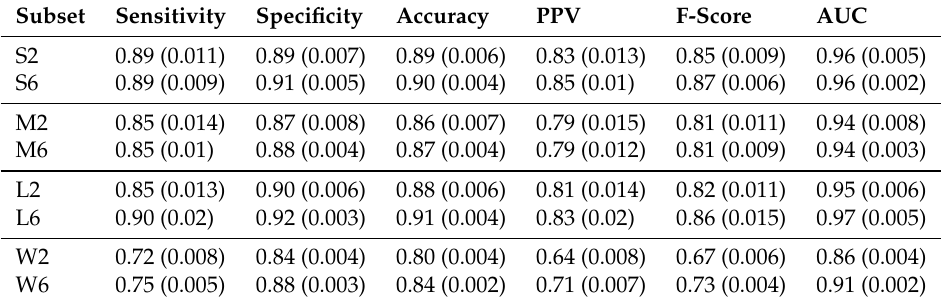
Table A5. Predictive performance of extreme gradient boosting based on the estimated sensitivity, specificity, accuracy, positive predictive value (PPV), F-score and the area under receiver operating characteristic curve (AUC) for two-week and six-week restriction period among the cows in early (S), mid (M) and late (L) lactation stage using cross validation